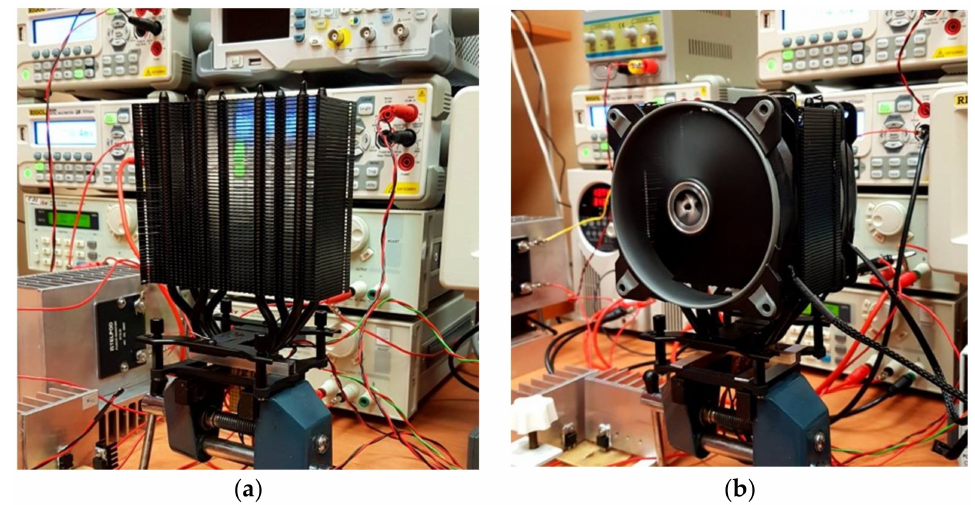
Figure 4. Cooling system ( a ) F and ( b ) G.